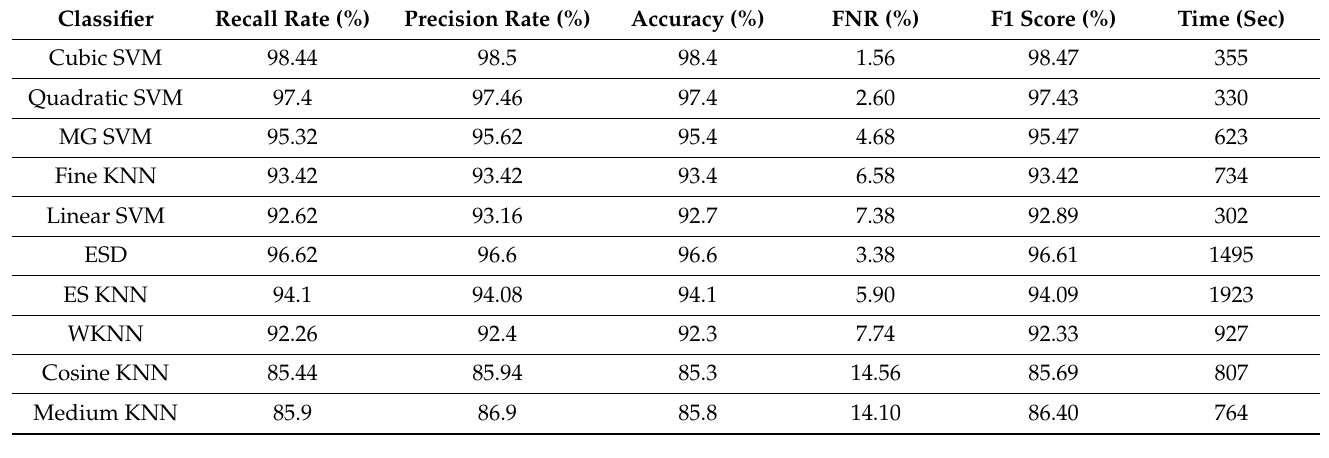
Table 6. Classification results of fine-tuned Densenet201 deep model after data augmentation.